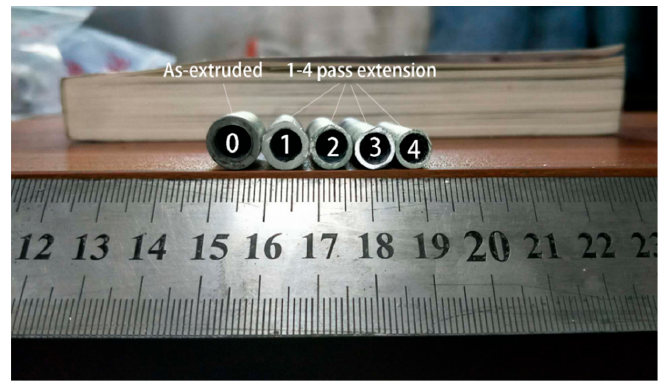
Figure 3. The extruded and four pass extended tubes.